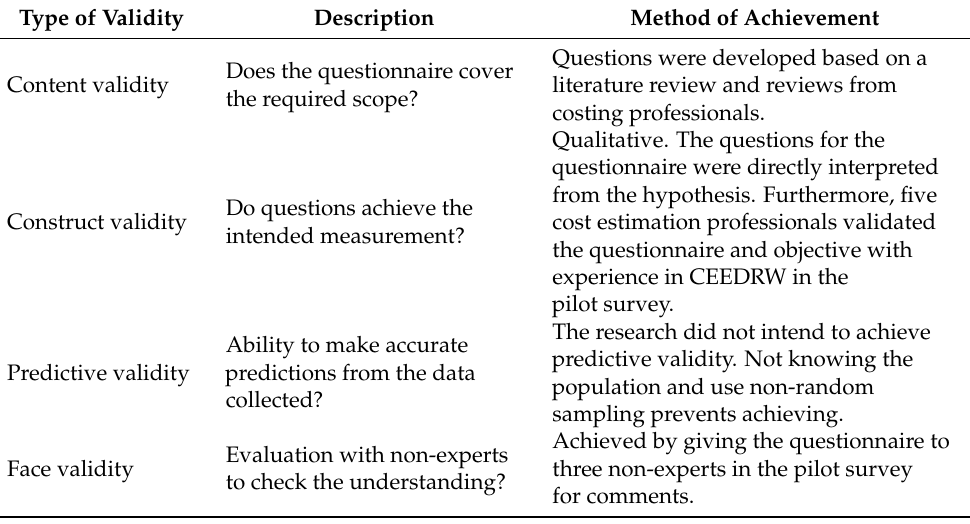
Table 3. Method of achieving the required validity of the